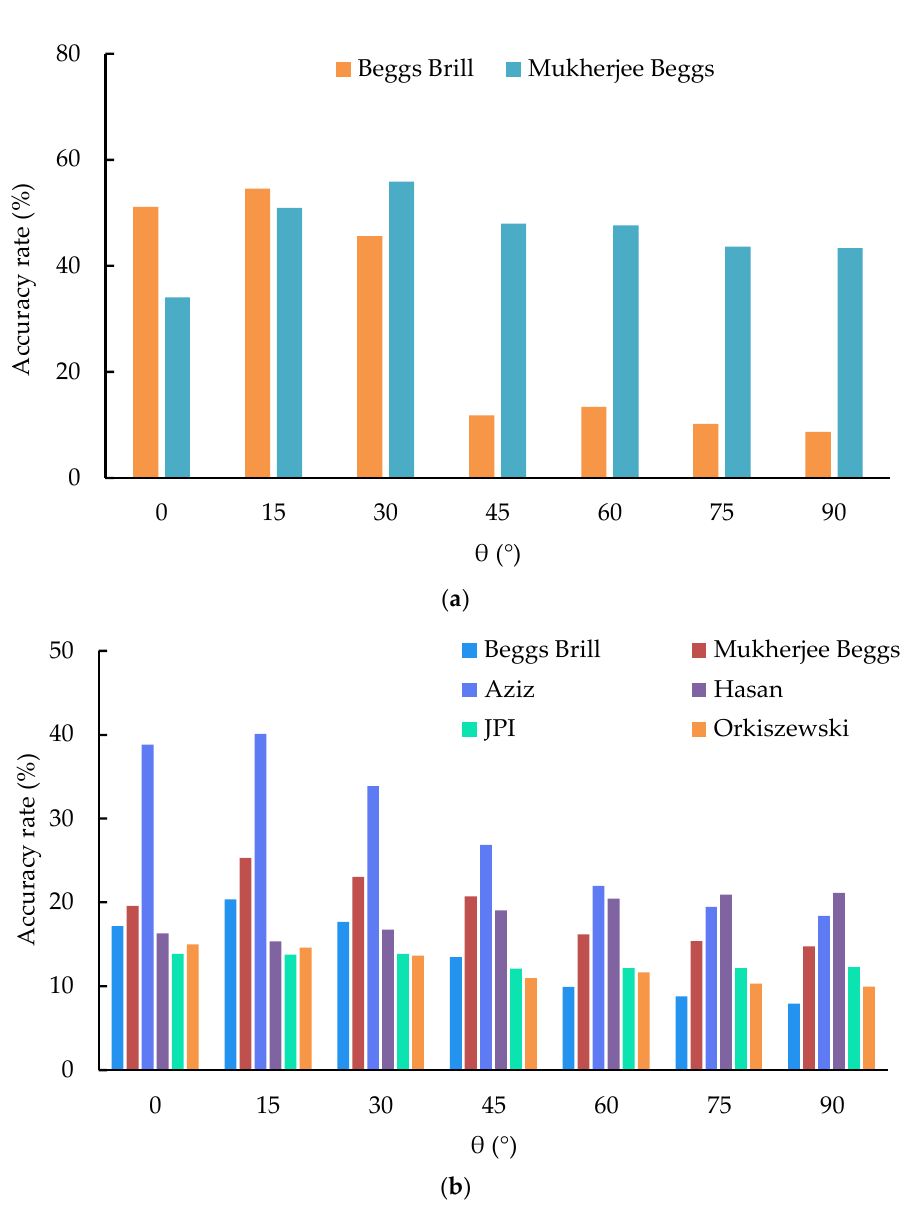
Figure 6. Verification of liquid holdup and pressure drawdown: ( a ) verification of liquid holdup; ( b ) verification of pressure drawdown.